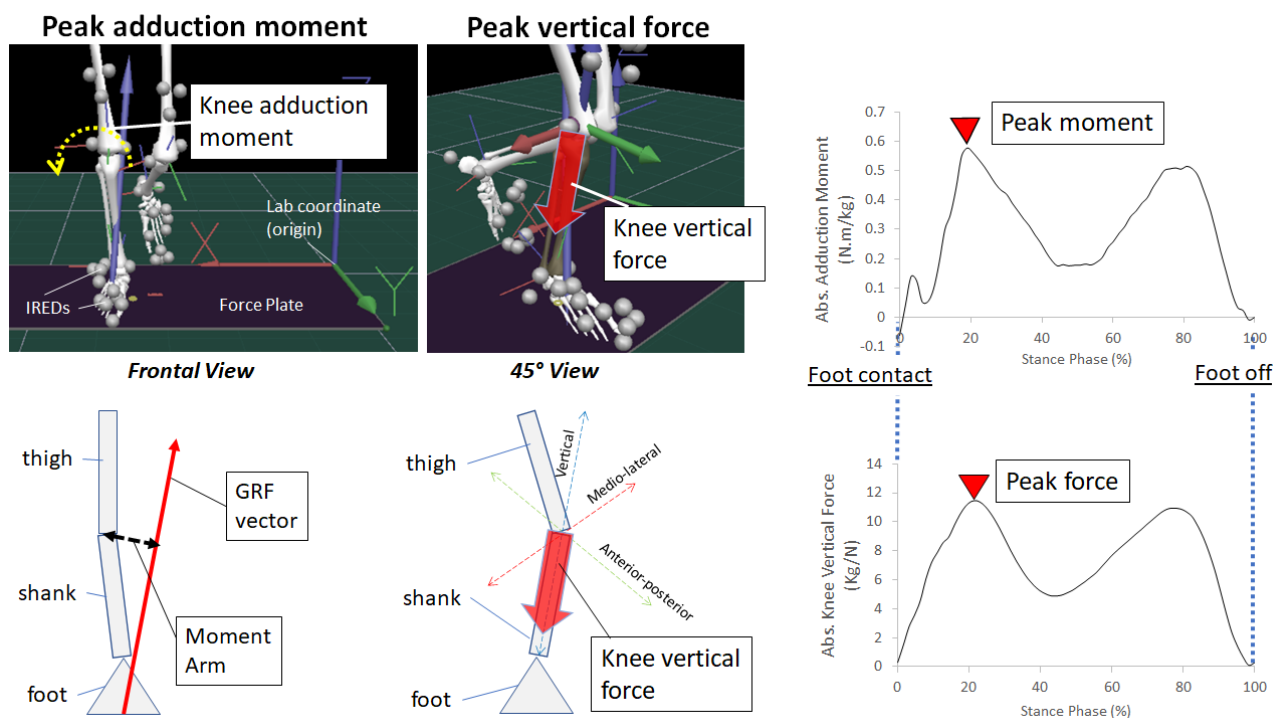
Figure 1. Knee joint biomechanics during loading. ( Left ): Two views of knee adduction moment and vertical force relative to the joint’s local coordinate system. ( Right ): Absolute knee adduction moment and absolute vertical force at stance phase time intervals; normalised by body mass; data taken from a single walkthrough trial of a healthy male (26 years, 1.75 m, and 70 kg).